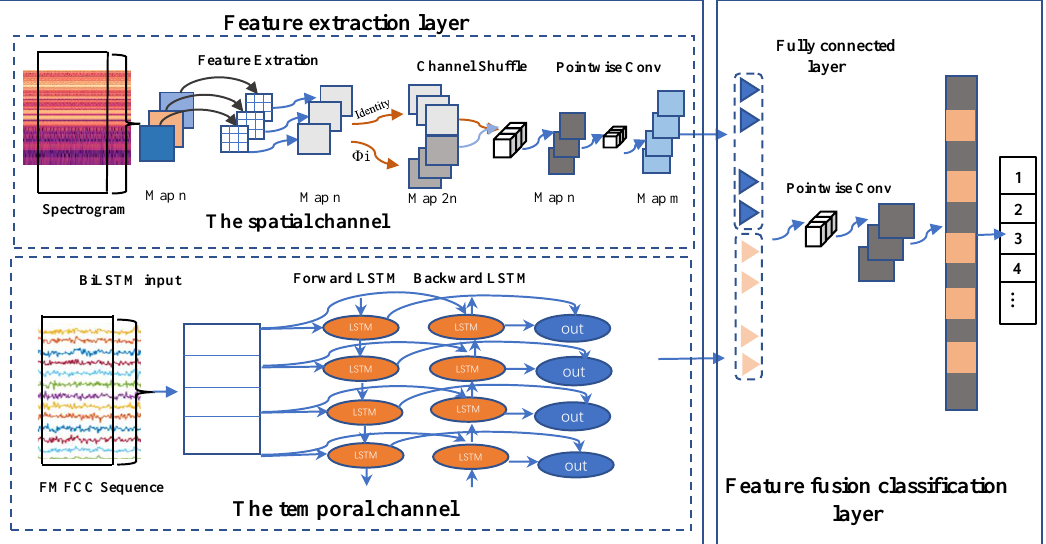
Figure 5. The network structure.